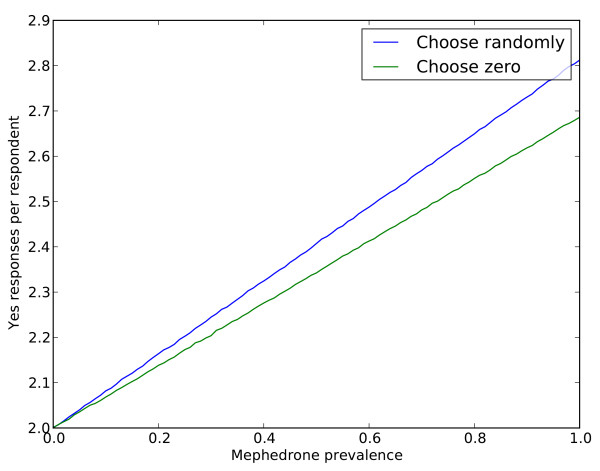
Comparison of the simulated probability distributions under two scenarios: A) '0 & 5' combined and B) 'any other option' to avoid exposure (n = 1,000,000).